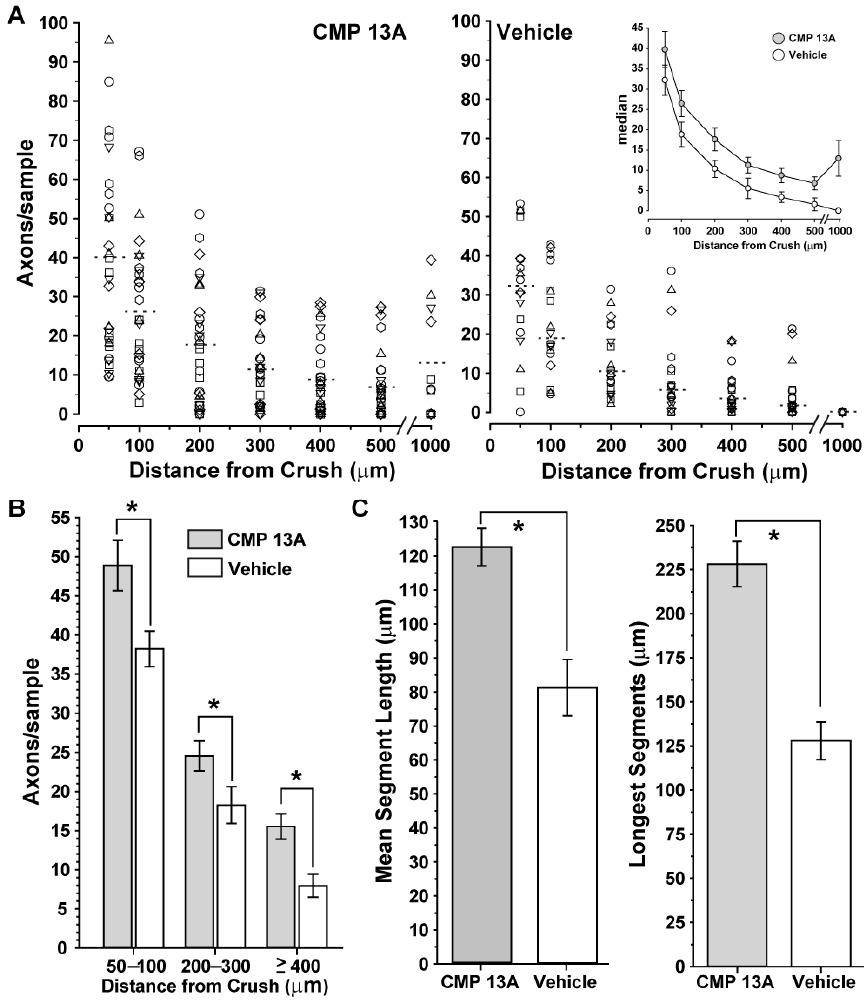
Figure 4. Collagen mimetic peptide increases axon recovery following nerve crush. ( A ) Number of CTB+ axon segments at specific distances distal to the injury site two weeks following optic nerve crush in individual samples (symbols), normalized to nerve width as described (see Methods). At each location, the median number of scored axons (dashed lines) in nerves from CMP 13A eyes